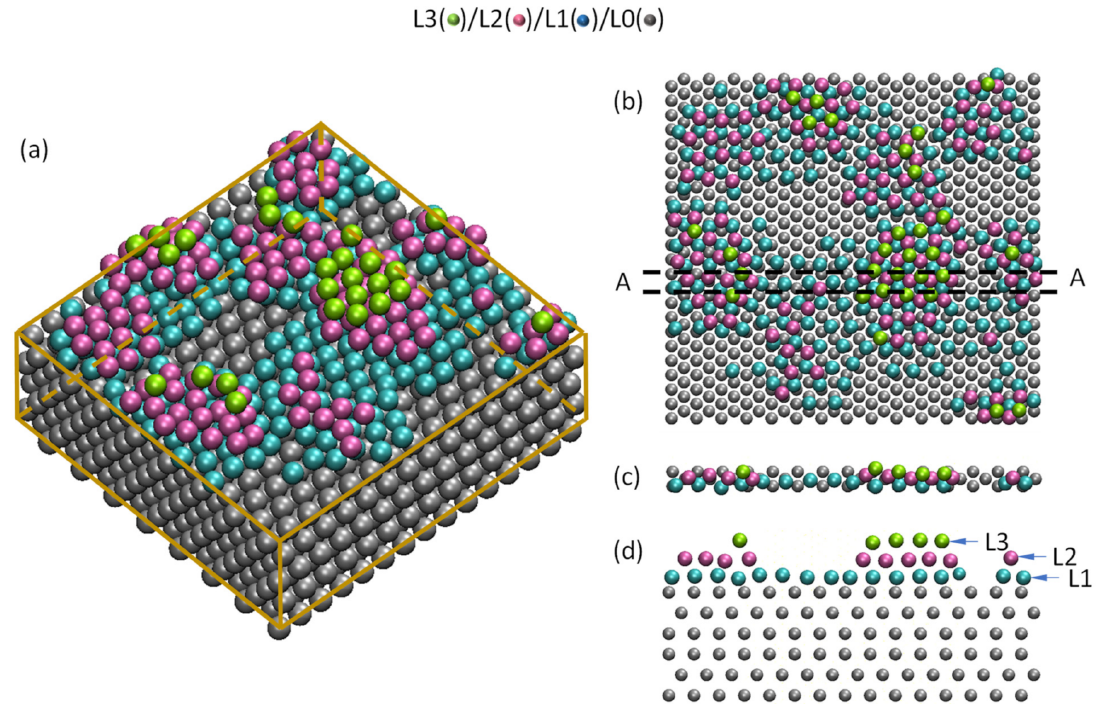
Figure 2. 2D ordered structure at the onset of heterogeneous nucleation. ( a ) A 3D view and ( b ) a top view of the arrangement of solid atoms on the substrate at the onset of heterogeneous nucleation ( t = 0 ps and T n = 760 K) in the system with − 8% misfit showing a 2D ordered structure as a consequence of structural templating; ( c ) a top view and ( d ) a front view (A-A slab section) of ( b ) showing the arrangement of solid atoms in the diffuse L/N interface. The liquid atoms have been removed from the snapshot of the simulation system with the local bond-order